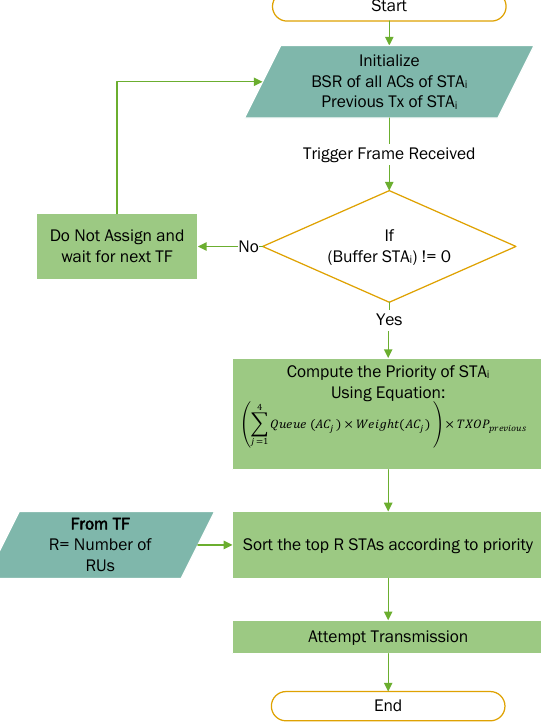
Figure 4. The flowchart of the proposed